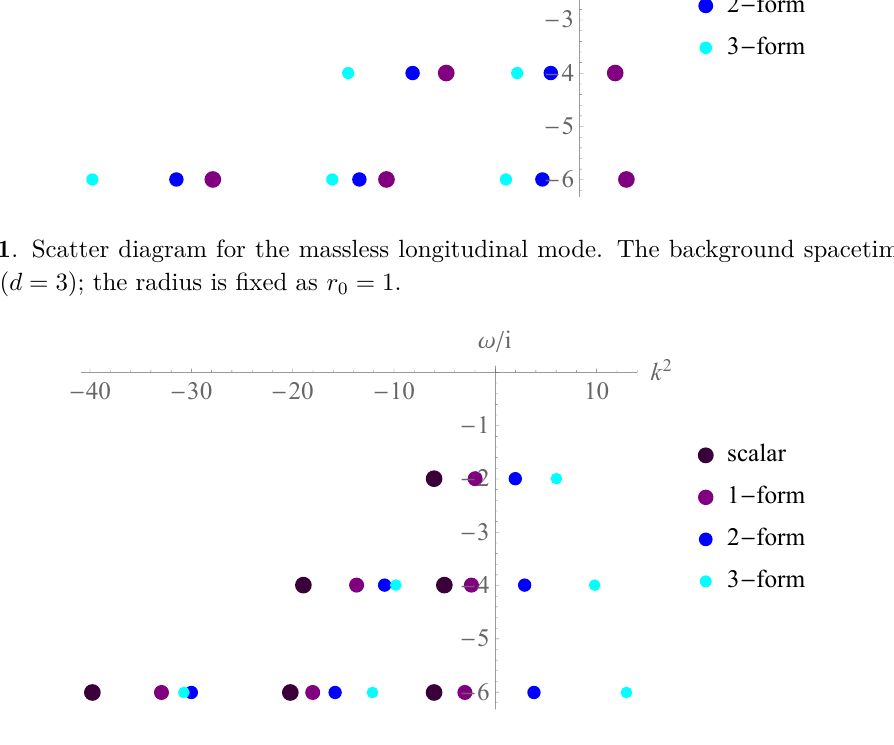
Figure 2 . Scatter diagram for the massless transverse mode. The background spacetime is set as AdS ( d = 3) ; the radius is fixed as r = 1 . Caveat: the transverse mode of 3-form does not exist 5 0 physically in five dimensions. These points are evaluated with an extension of the p